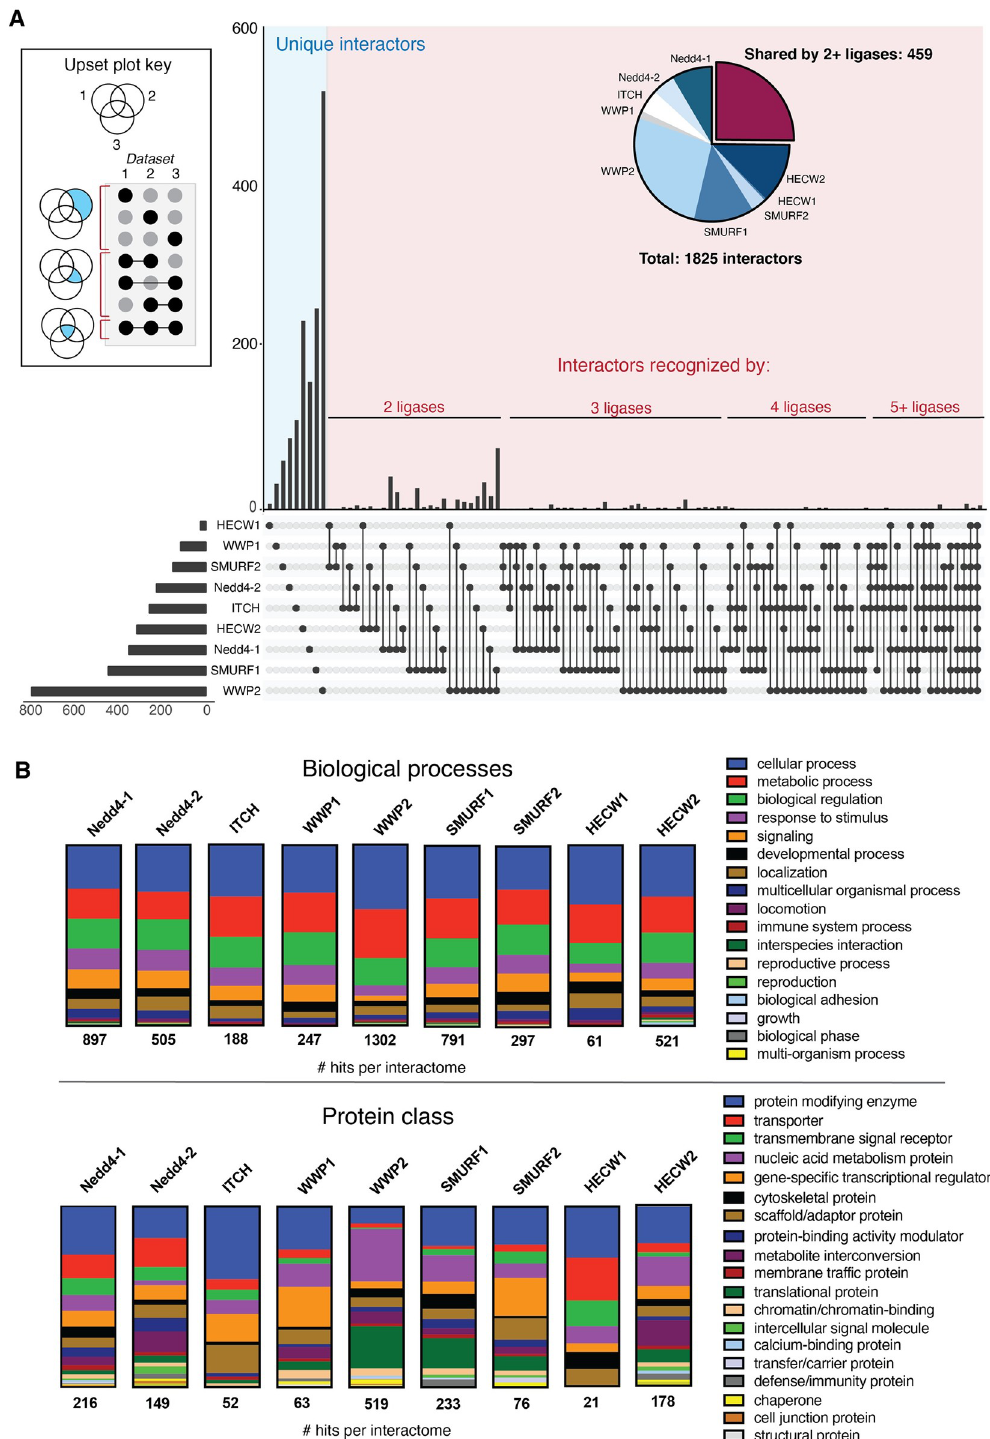
Fig 2. UpSet analysis and Gene Ontology annotation reveal that Nedd4 family ligases are functionally distinct. (A) Cross-reference of annotated interactors in the BioGrid database reveals that approximately one quarter of all interactors of the Nedd4 family are recognized by 2+ ligases, revealing little overlap in the known interactomes of the Nedd4 family. Data analysis performed with the UpSet plot tool [76] and graphic annotated in Adobe Illustrator. (B) Gene ontology analysis via the PANTHER database [43, 44] reveals that each Nedd4 family ligase interactome has similar trends in biological process (top) but distinct patterns in protein class composition (bottom).